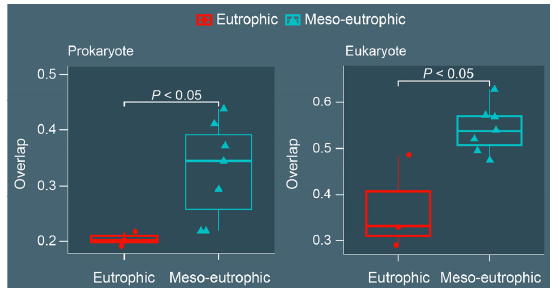
Figure 5. The boxplots for overlaps of richness between eutrophic region and reference data, and between meso-eutrophic region and reference data for prokaryotes and eukaryotes, respectively. The significance based on Wilcoxon test.